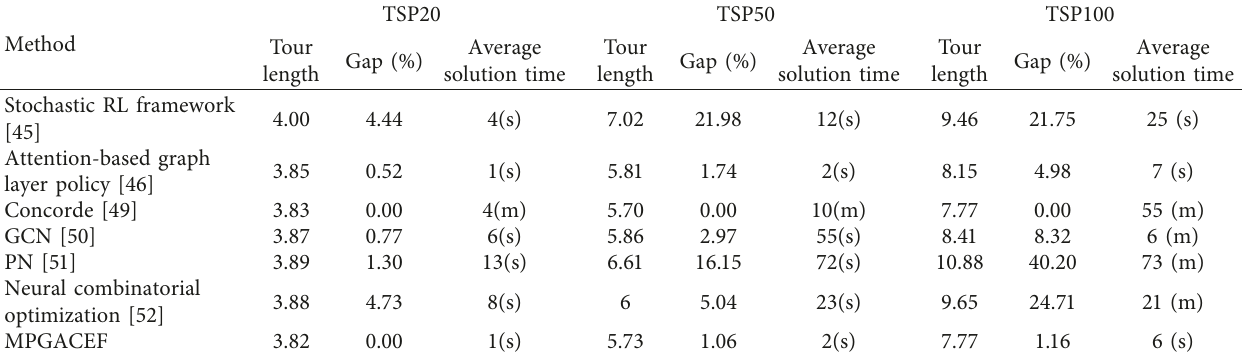
Table 3: The average tour length, gap percentage, and average solution time of TSP.